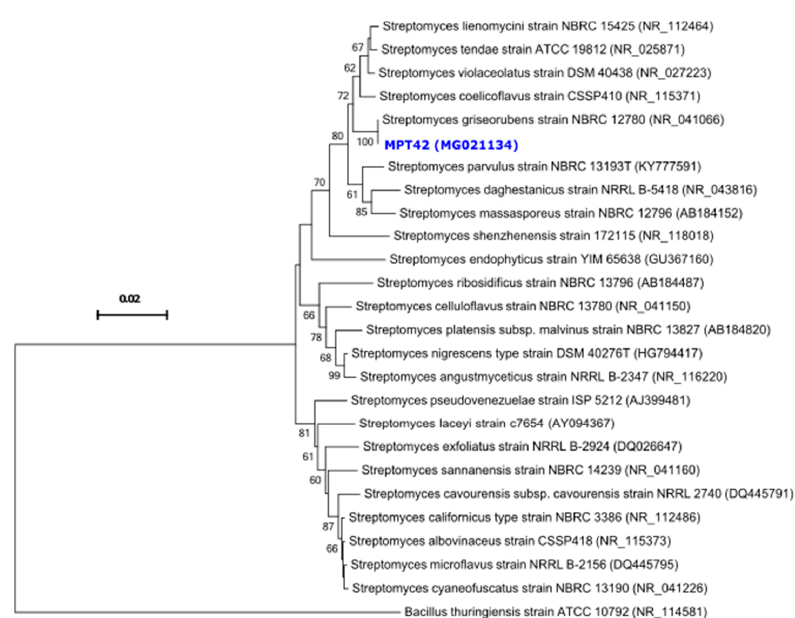
Figure 2. Neighbor-joining phylogenetic tree based on 16S rRNA gene sequences of Streptomyces griseorubens MPT42 and type strains retrieved from GenBank (accession numbers are shown in parentheses). Bacillus thuringinensis strain ATCC 10792 was used as the outgroup. Only bootstrap values >50% are shown.